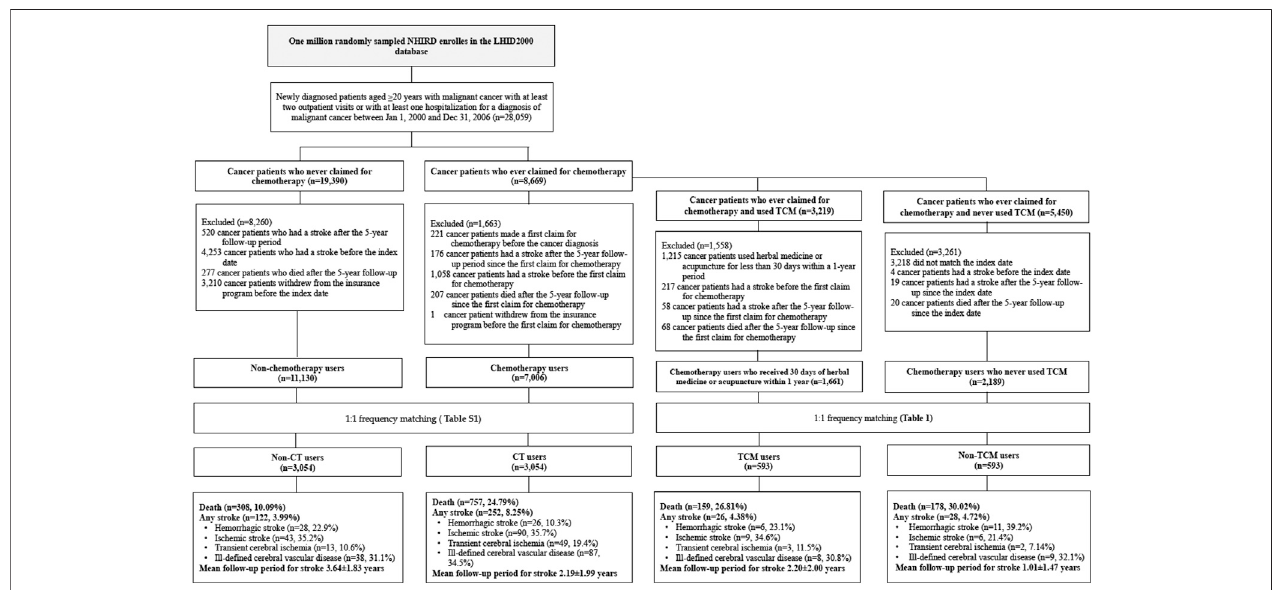
FIGURE 1 | Flowchart of study subject enrolment from the Longitudinal Health Insurance Database 2000 (LHID2000), a sub-dataset of Taiwan ’ s National Health Insurance Research Database (NHIRD), from January 2000 to December 2006. Abbreviations: CT, chemotherapy; TCM, traditional Chinese